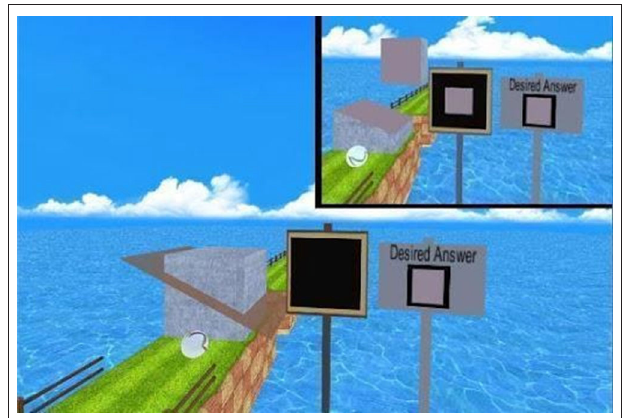
FIGURE 3 | A level from “Keep the Ball Rolling” (Bottom: A desired slice to create; Inset: the slice created by the user).